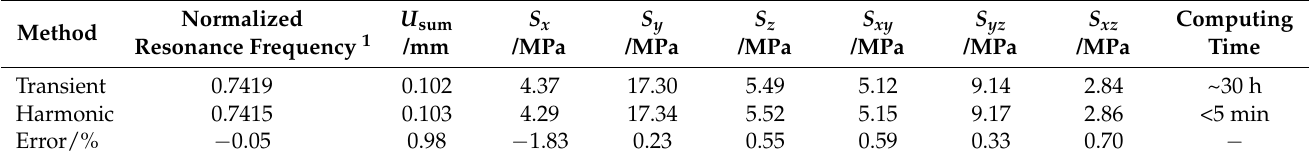
Table 2. Relative deviation of the harmonic analysis to the transient